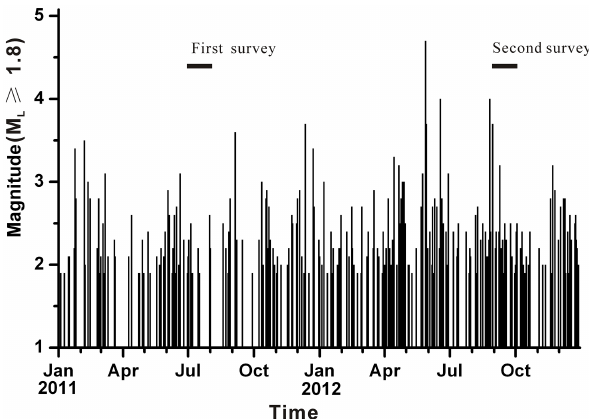
Figure 12. The earthquakes as a function of time for 2011 and 2012 in the capital area of China. The graph shows the local magnitudes for all earthquakes with M L ≥ 1 . 8, as a function of day of occur- rence, from 1 January 2011 to 31 December 2012 (data from China Earthquake Data Center,